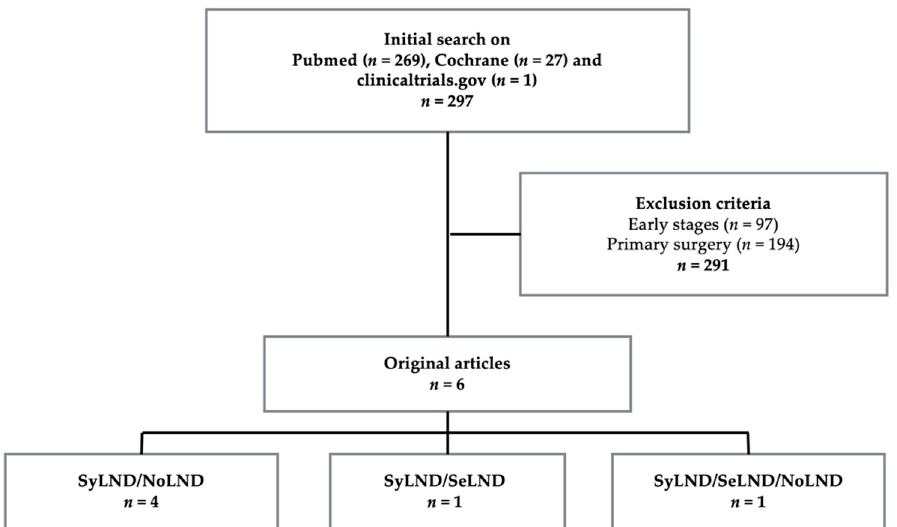
Figure 1. Study selection flowchart. SyLND = systematic lymph node dissection, SeLND = selective lymph node dissection, and NoLND = no lymph node dissection.